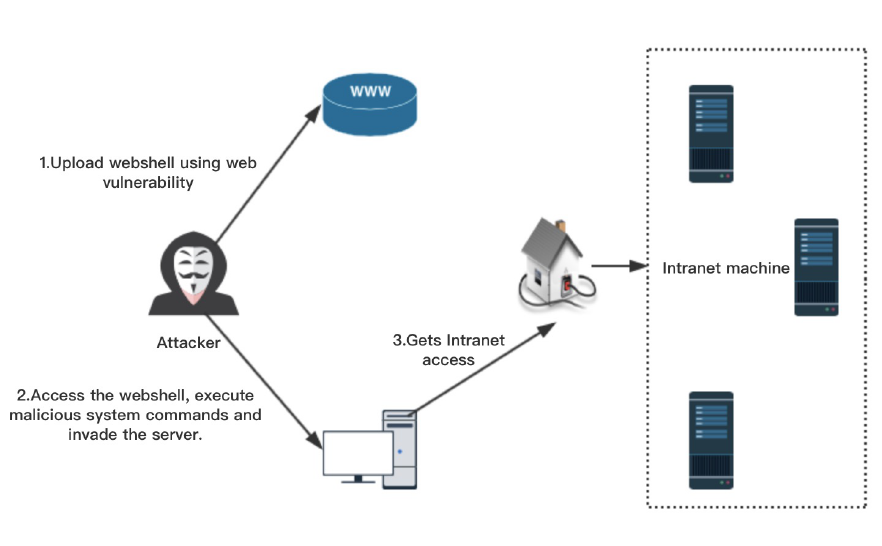
Figure 1. Webshell attack